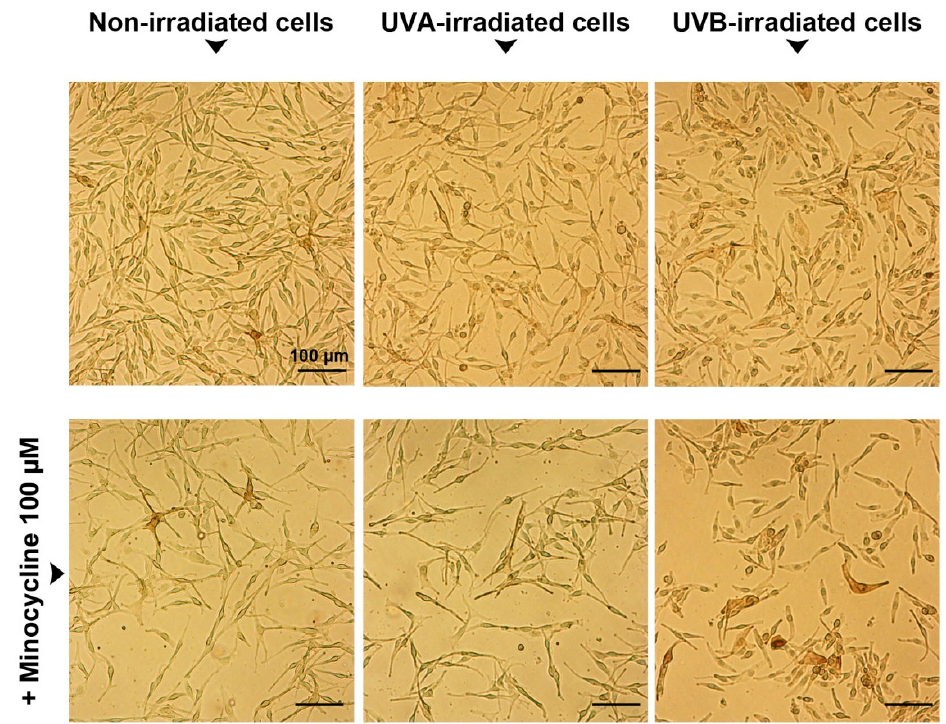
Figure 3. Microscopic evaluation of human normal melanocytes treated with 100 µ M of minocycline and exposed to UVA and UVB radiation. Scale bar 100 μ m.